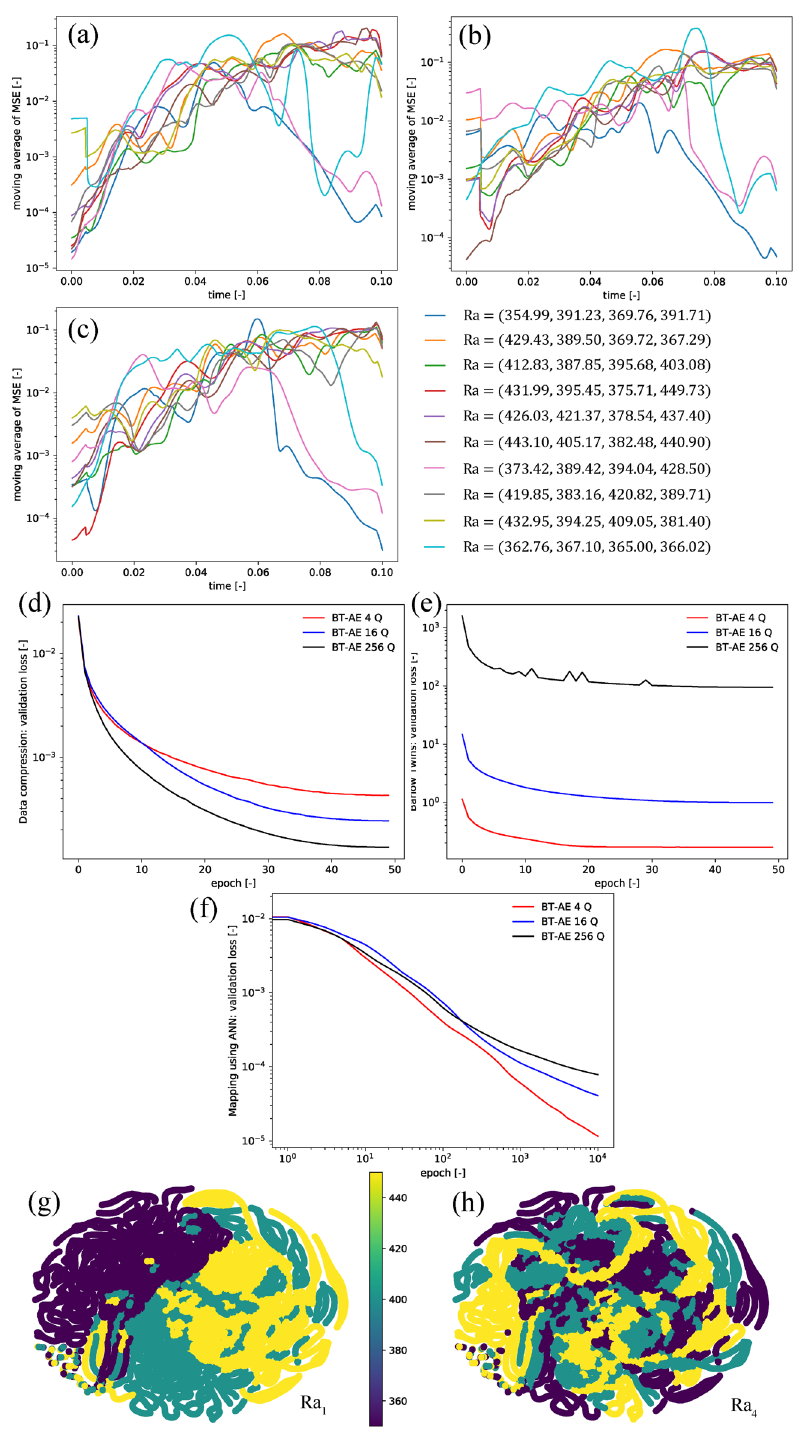
Figure 5. Example 4 results: the moving average (a window size of 50) of mean squared error (MSE) of ( a ) BT– AE 4 Q, ( b ) BT–AE 16 Q, ( c ) BT–AE 256 Q (please refer to Table 2). ( d ) Data compression loss for validation set (Eq. 18), ( e ) Barlow Twins loss for validation set (Eq. 14), ( f ) mapping using ANN loss for validation set (Eq. 19), and latent space plot of BT–AE 16 Q model for ( g ) Ra 1 and ( h ) Ra 4 . Latent space plots are constructed using t-Distributed Stochastic Neighbor Embedding (t-SNE). Different colors represent each value of Ra value. We calculate the t-SNE plots using Scikit-Learn package using its default setting and perplexity of